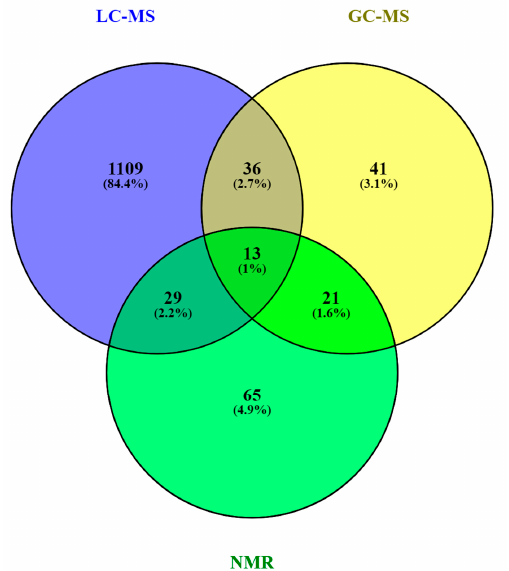
Figure 4. Venn diagram of metabolites reported in human milk (HM) according to the technique in